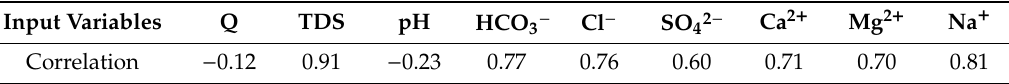
Table 2. Pearson correlation coe ffi cient between EC and input water quality variables.